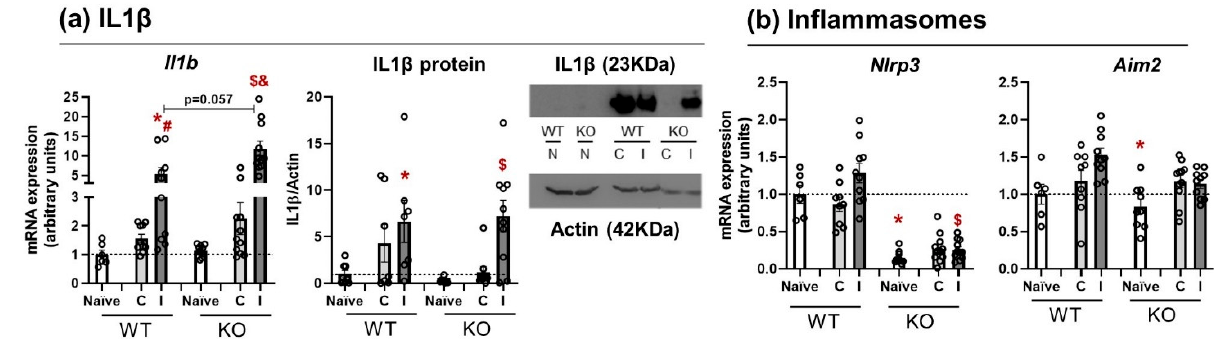
Figure 2. IL1 β signaling in WT and NLRP3 KO mice 24 h after the lesion. ( a ) Changes in Il1 β mRNA ( left ) and protein expression ( center ) in WT and KO mice. Naïve, contralateral, and ipsilateral sides were compared in both strains. Representative Western blot image of IL1 β protein and actin is shown ( right ). ( b ) Changes in Nlrp3 and Aim2 mRNA levels in WT and KO. Naïve, contralateral, and ipsilateral sides were compared in both strains. Mean ± SEM ( n = 6–11). Kruskal–Wallis or two-way ANOVA followed by Mann–Whitney or Bonferroni’s tests p ≤ 0.05. (* vs. WT Naïve; # vs. WT Contra; $ vs. KO Naïve; & vs. WT Ipsi (WT: wild type; KO: NLRP3 knockout; C: contralateral; I: